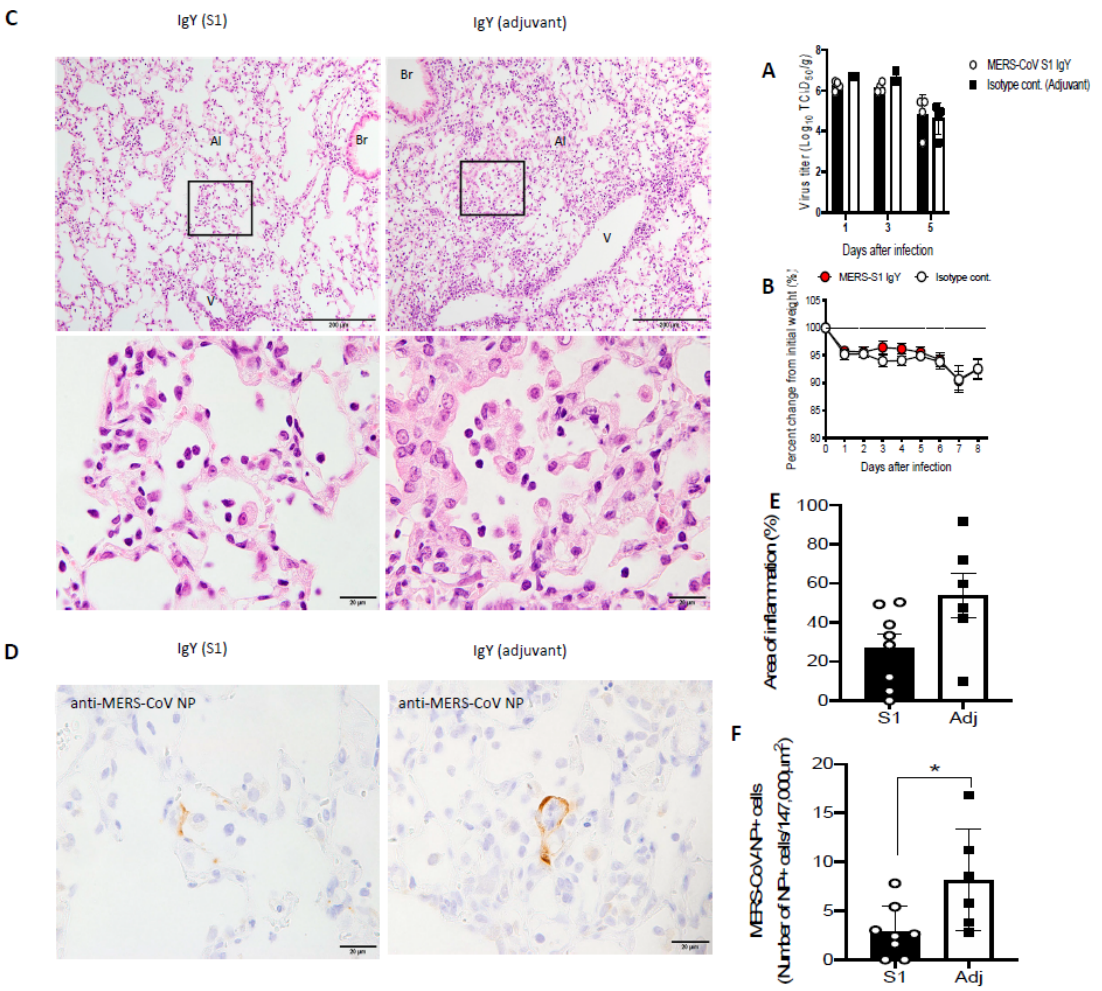
Figure 8. ( A ) Viral titer in the lungs of MERS-CoV mice treated with anti-SI IgY antibodies and control IgY (adjuvant). ( B ) Body weight changes after MERS-CoV infection between anti-SI IgY antibodies and IgY of adjuvant control group. ( C – F ) Histopathology of the lungs from human dipeptidyl peptidase 4 (hDPP4)-transgenic mice on day 8 after inoculation with MERS-CoV. Representative histopathological findings of mice with the highest cellular infiltration in alveoli by H&E staining ( C ) Massive mononuclear cell infiltrations including macrophages and lymphocytes with regenerated type II pneumocytes were seen in adjuvant control group (right column), but less in the anti-S1 IgY treated group (left column). Scale bars: 200 µm (upper row) and 20 µm (lower row). Al, alveoli; Br, bronchi; V, vessel. Detection of viral antigen in lung tissues of mice by immunohistochemistry ( D ) A few antigen positive cells were seen in the lungs of anti-S1 IgY treated group compared to adjuvant control group. Quantification of inflammation areas ( E ) The area of pulmonary lesion was determined based on the mean percentage of affected areas in each section of the collected lobes form each animal ( n = 8 or 6). Circles indicate averages from three observation lobes in each mouse. p = 0.1709 by Mann-Whitney test. Numbers of viral antigen positive cells in the alveoli ( F ) Data were obtained from 8 or 6 mice. Circles indicate averages of 5 observation fields in each mouse. * p = 0.0196 by Mann-Whitney test.